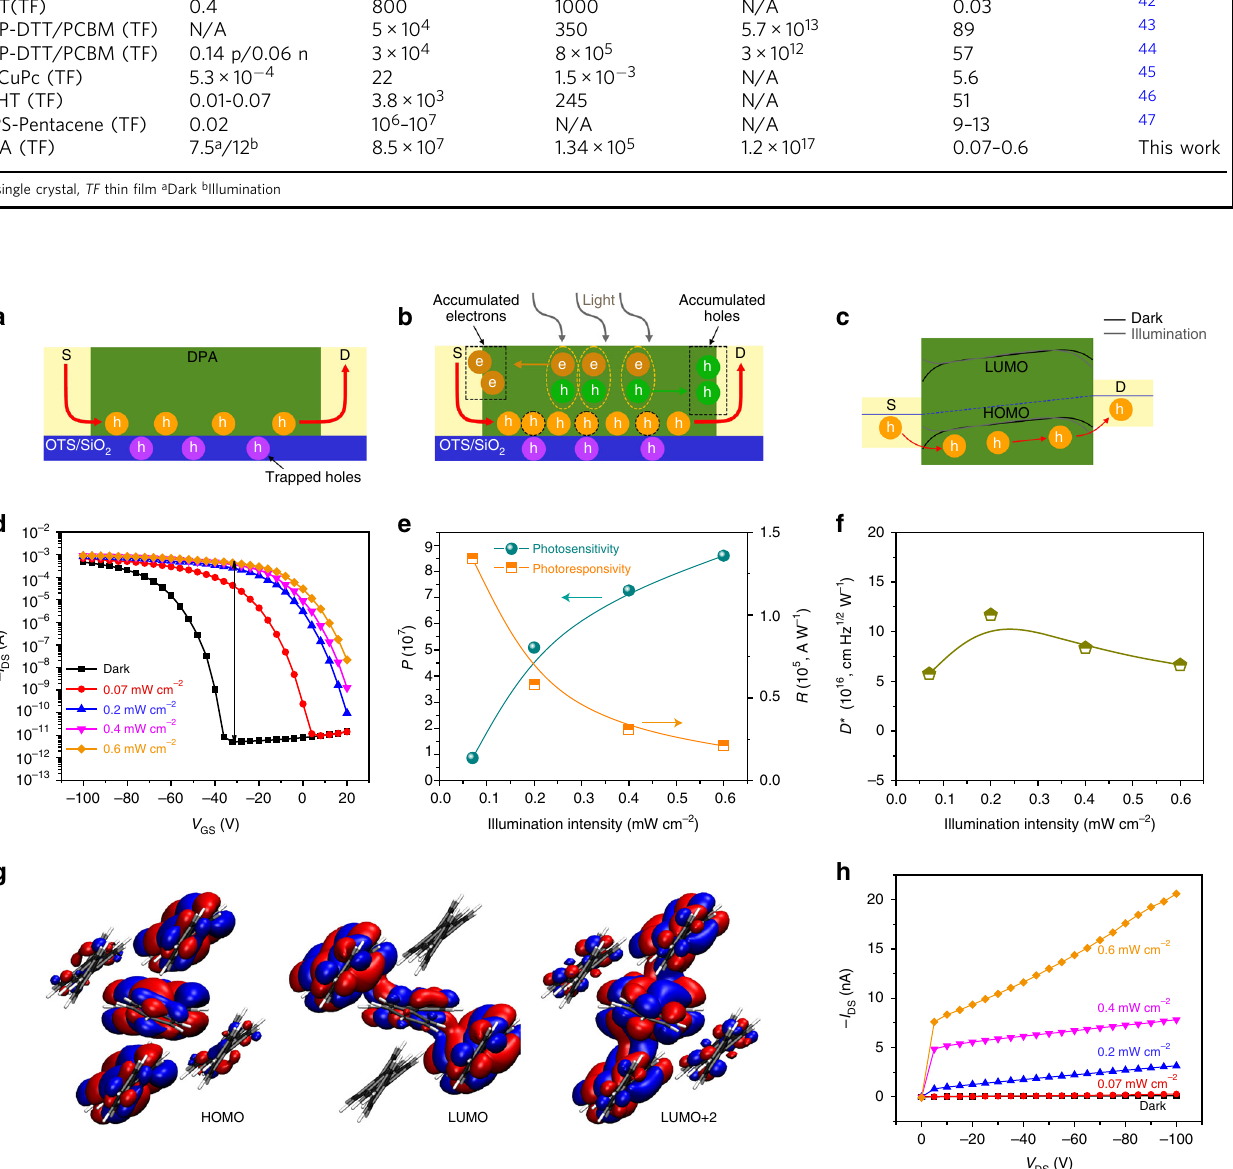
Fig. 3 Charge transfer mechanism and performance of the phototransistor. Charge transfer mechanism in dark ( a ) and under illumination ( b ). c Energy band diagram of electrode/semiconductor interface in dark and under illumination. d Transfer characteristics of DPA-based phototransistor measured under different illumination intensities in the air. e P and R as a function of illumination intensity. f D * as a function of illumination intensity. g Calculated molecular orbitals describing the fi rst electronic excitation ( E vert = 388.67 nm; f = 0.1331) at the TD-DFT level. h − I DS at various illumination intensities ( V GS = 0 V)